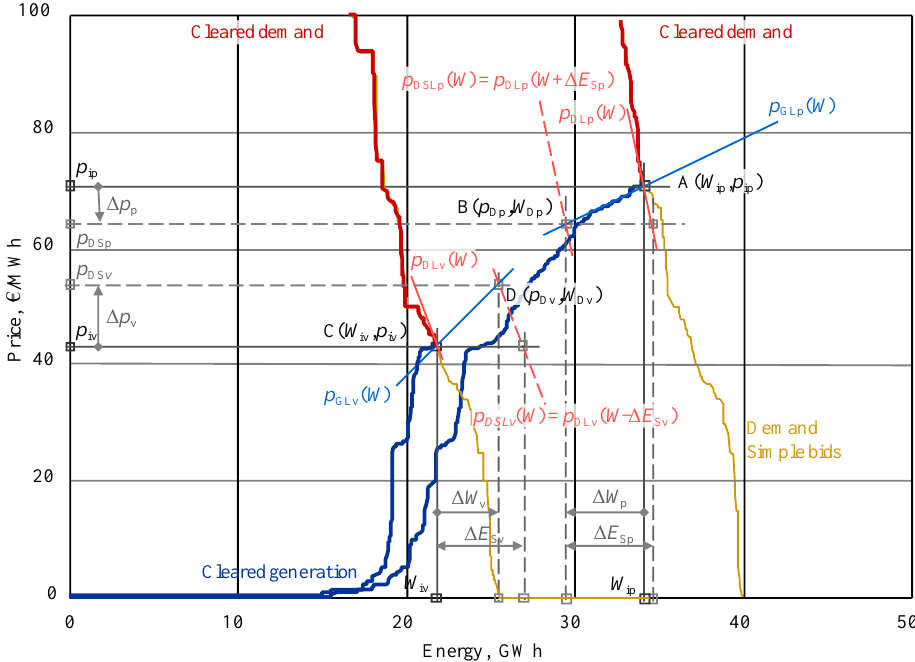
Fig. 2. Merit-order generation , p G (W), and demand, p D (W), curves for a valley (04:00 h) and peak (20:00 h) hours on a working day in winter corresponding to the Iberian market [16]. Changes in demand curves and market clearing points due to